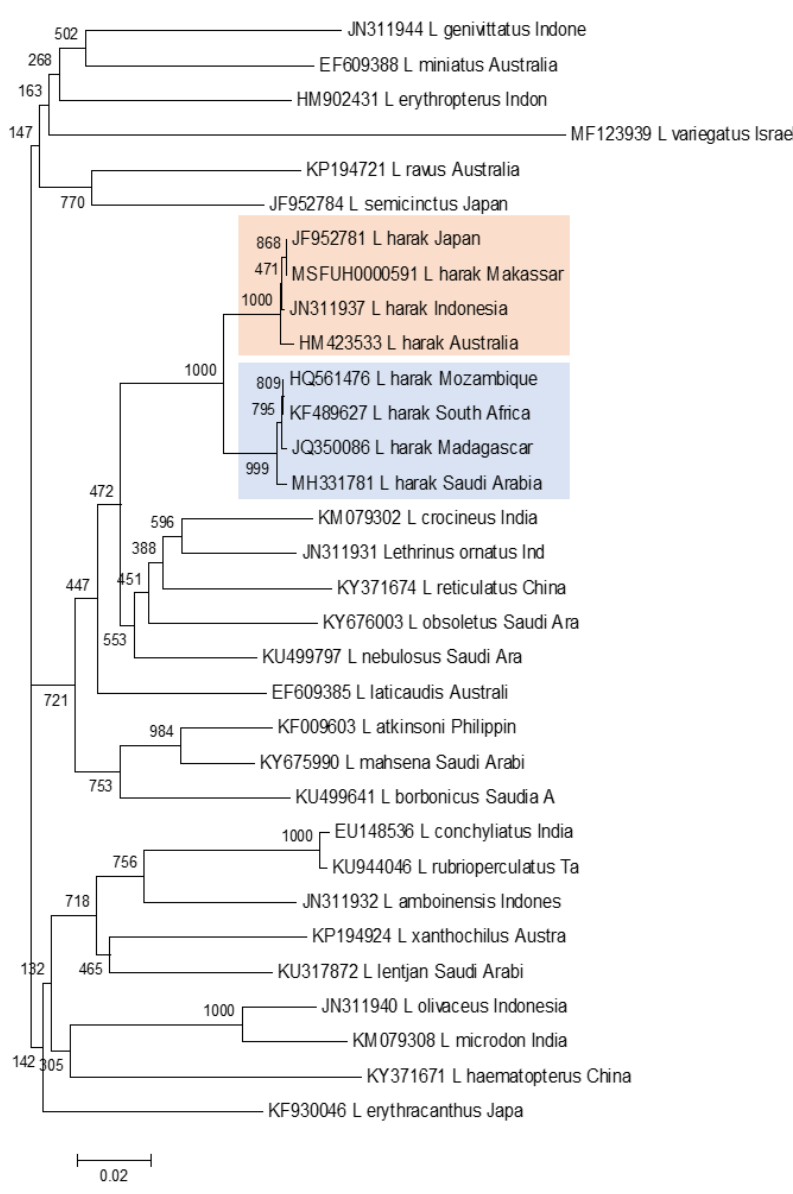
Figure 3. Phylogenetic reconstruction for eight Pacific and Indian Ocean L. harak populations, nested within the genus Lethrinus , using the neighbour-joining method with the Kimura 2-parameter model and bootstrapping with 1000 replicates.